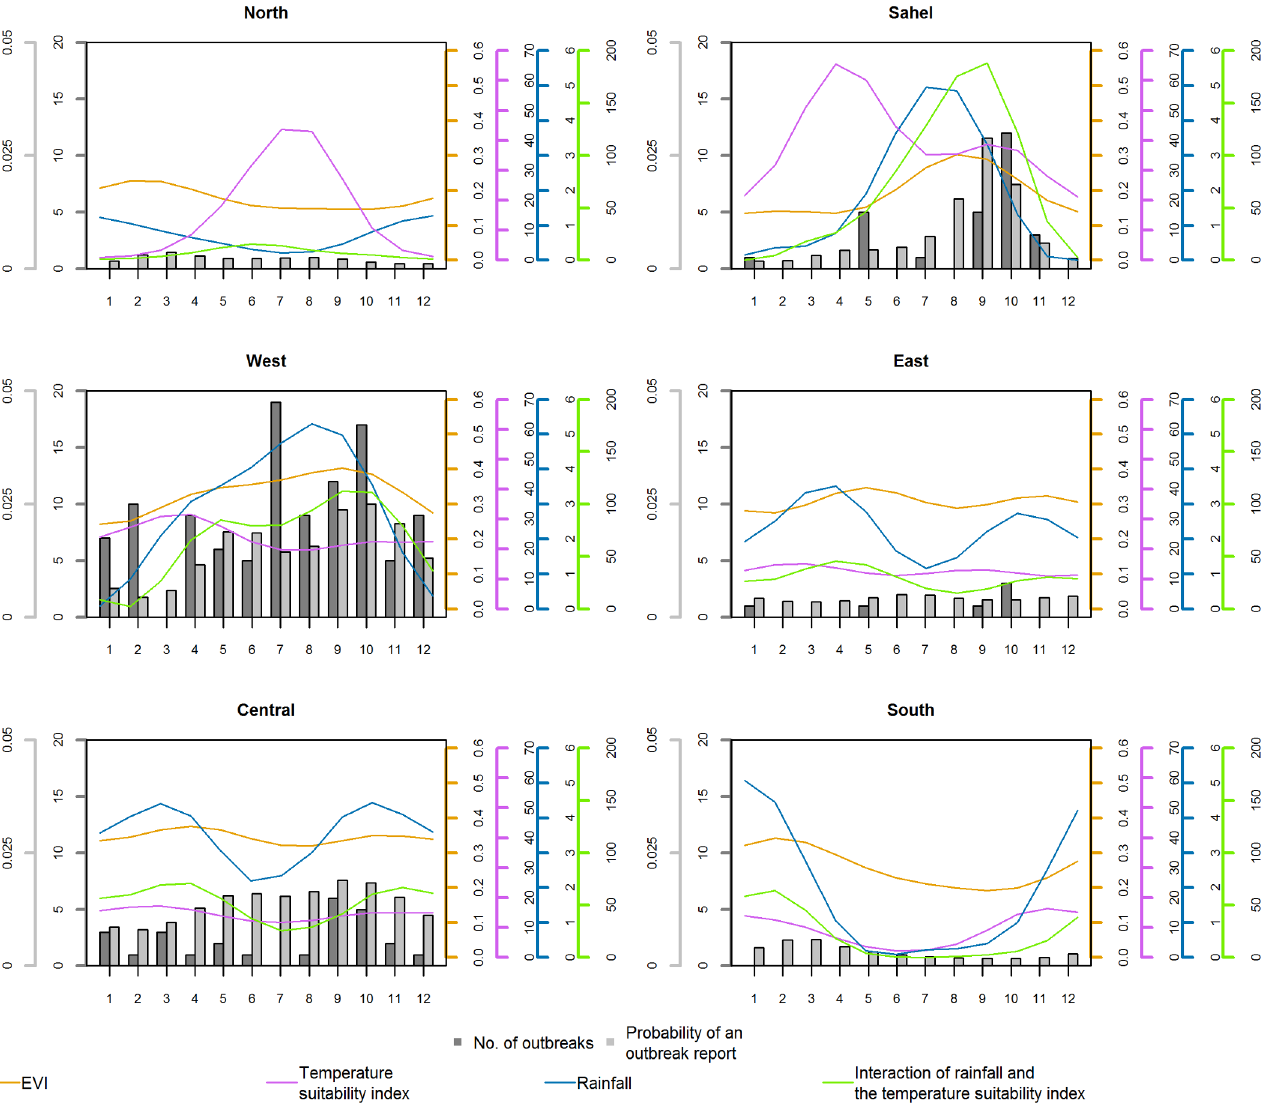
Fig 3. Seasonal patterns in YF reports and covariates by geographical region. Left axis (left to right): the mean monthly probability of YF reports and the number of YF reports. Right axis (left to right): monthly means of EVI, temperature suitability index, rainfall and the interaction of temperature suitability and rainfall. Colours of axes indicate covariate. See Fig 1 in S4 Text for classifications of different regions of